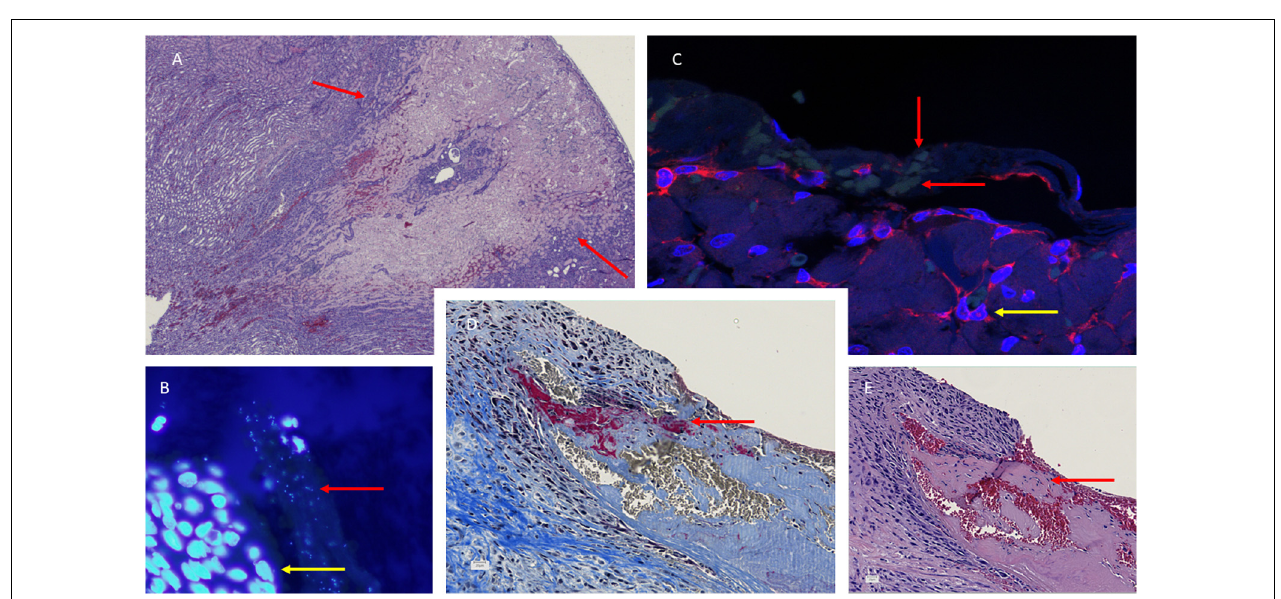
FIGURE 4 | Histology of the aortic valves (B–E) and kidney necrosis (A) in S. aureus infective endocarditis (IE) experimental rat model. Hematoxylin-eosin (HE) staining reveals the large necrosis in the cortex of the kidney in a rat with IE. Representative sections of S. aureus infected valve [ (B) , fluorescens microscope × 100 and (C) , confocal microscope, × 62] with DAPI/PNA-flourescence in situ hybridization (FISH) stain showing S. aureus microcolonies in valve vegetations, red arrow indicating the microcolonies and yellow arrow indicating recruited polymorphonuclear neutrophils. Martius, Scarlet, and Blue (MSB) and hematoxylin-eosin (HE) (E) reveals fibrin in red indicated (D) and amorphous structures (E) in valve vegetations indicated by red arrow, respectively.